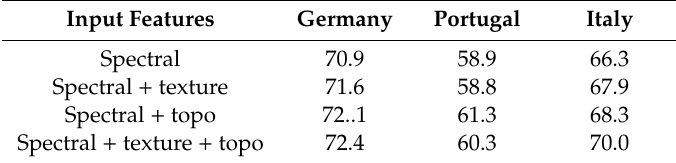
Table 3. Overall accuracies (%) for di ff erent input features used in the classification